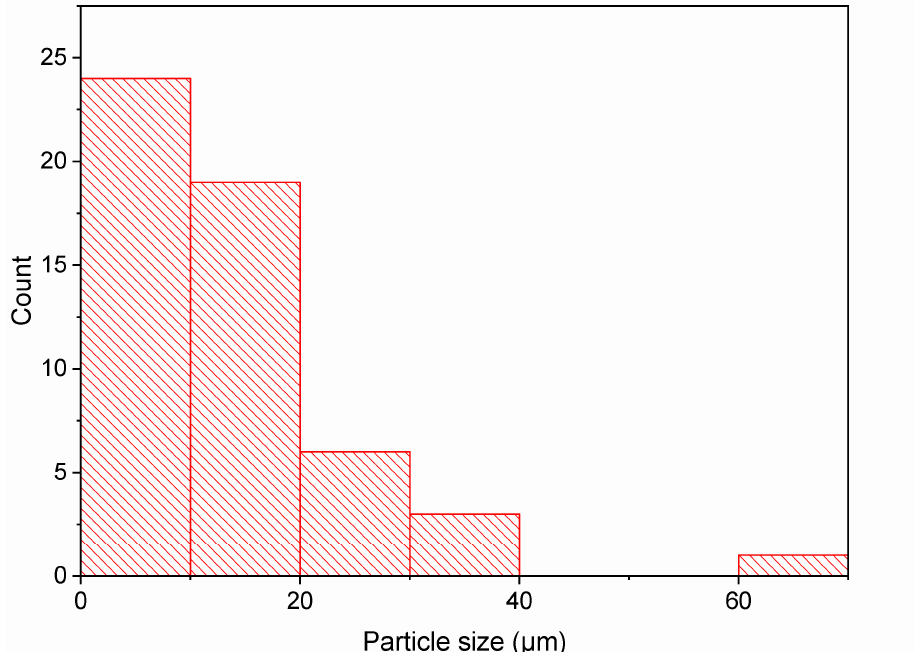
Figure 5. Particle size distribution.